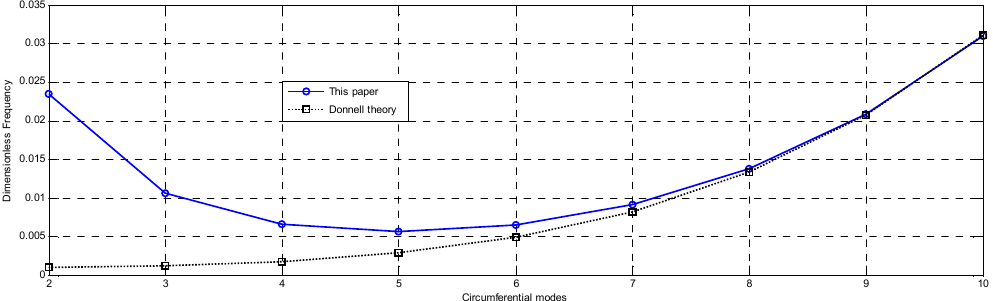
Figure 2. Frequency comparison between this study and Donnell’s theory.